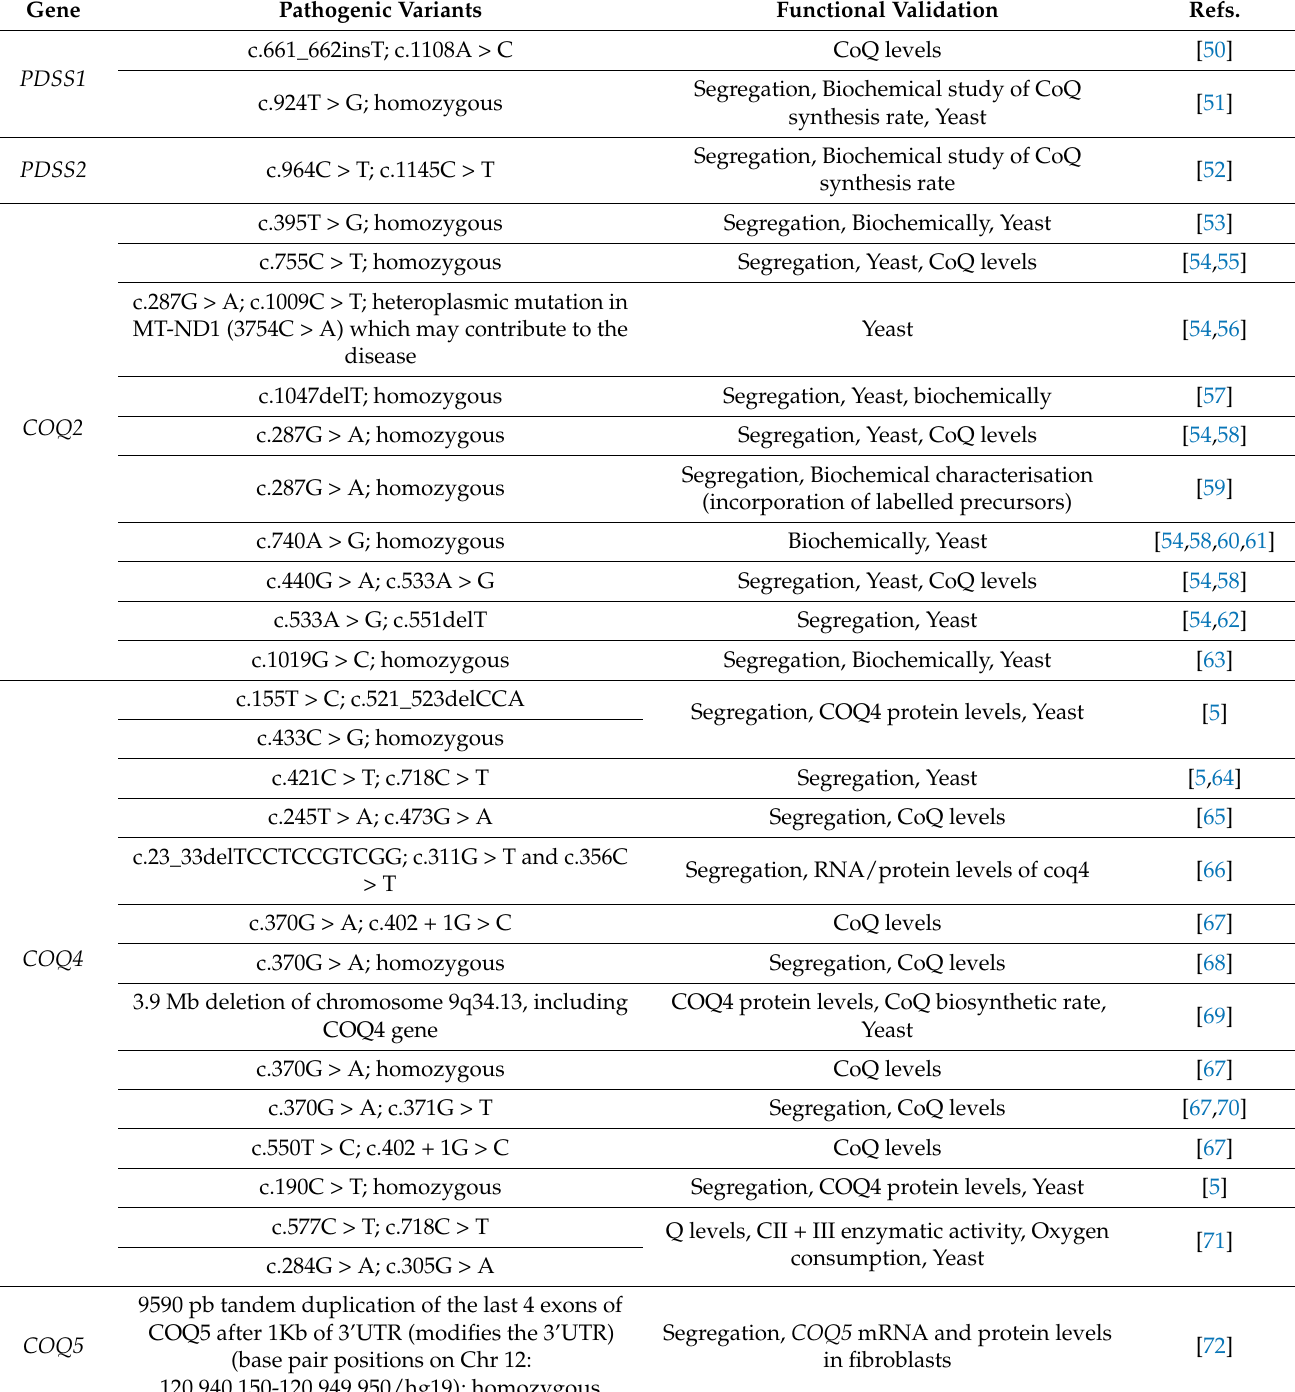
Table 2. Pathological COQ